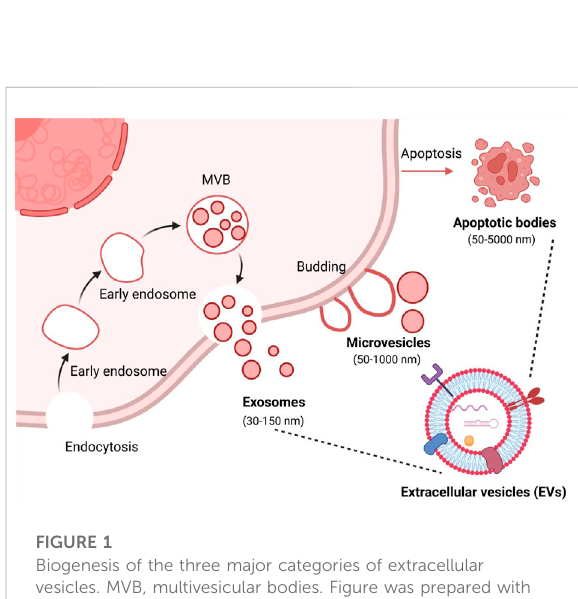
FIGURE 1 Biogenesis of the three major categories of extracellular vesicles. MVB, multivesicular bodies. Figure was prepared with BioRender ®